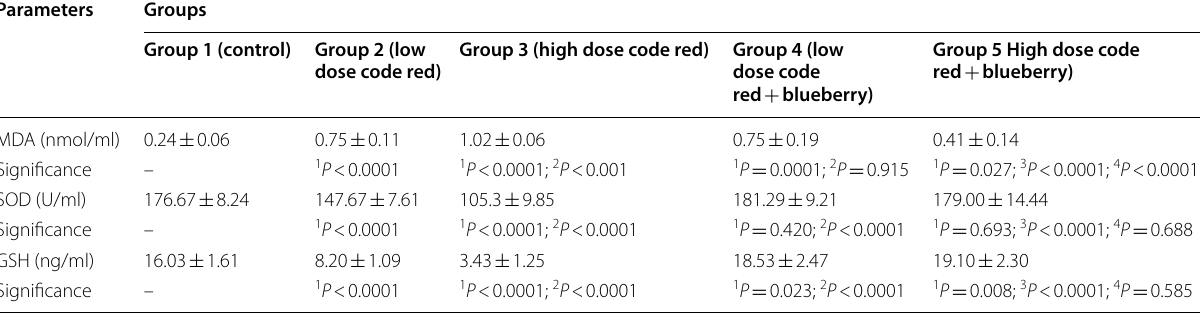
Data are shown as mean SD derived from six blood samples obtained from the six rats in each group. The statistical significance ( P value) between different groups ± is calculated, and the P < 0.05 are considered statistically significant 1 P : significance versus group 1 (Control); 2 P : significance versus group 2 (Low dose Code Red); 3 P : significance versus group 3 (High dose Code Red); 4 P : significance versus Group 4 (Low dose Code